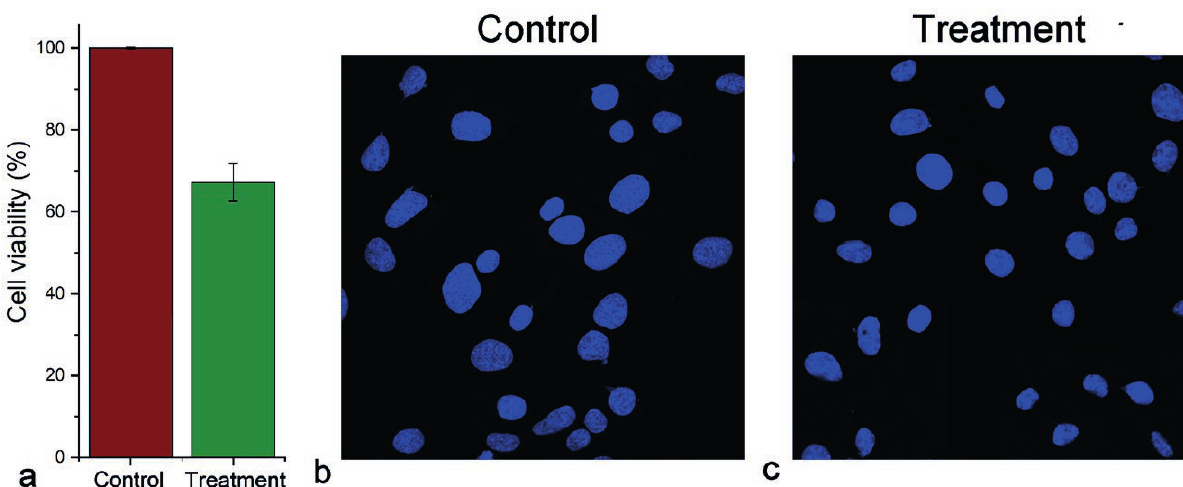
Figure 2. K7M2-pCl bone cancer cell viability (a) and fluorescent optical images (b-c) showing the K7M2-pCl cell nuclei stained in blue 24 h after the onset of the treatment for the control (a, b) and the treated (a, c) population. Dimensions of the images (b) and (c) are 270 x 270